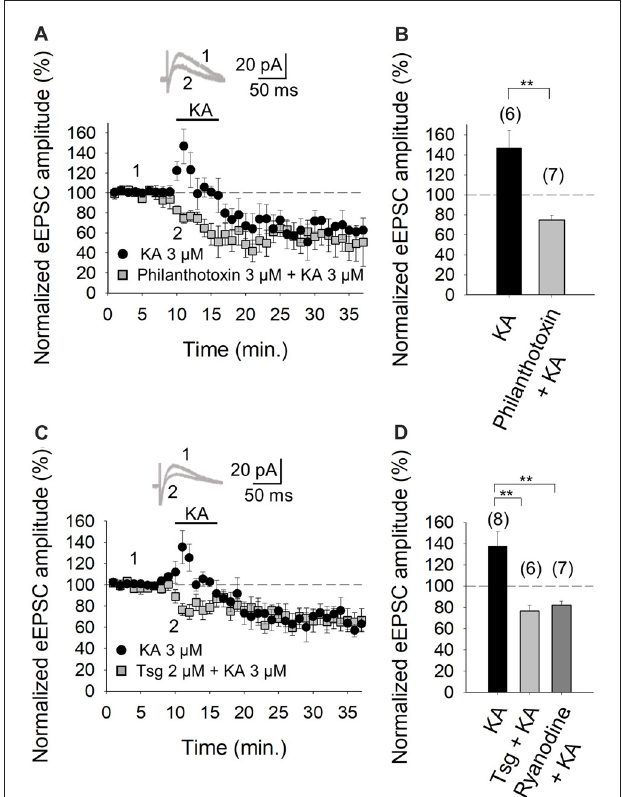
FIGURE 3 | Facilitation of glutamate release mediated by presynaptic kainate receptor (KAR) activation requires an increase of Ca 2 + in the cytosol at PF-PuC synapses. (A) Time-course of KA (3 µ M) effect on eEPSCs amplitude in control condition (circles) and in slices treated with philanthotoxin (squares). (B) Quantification of modulation observed in (A) . (C) Time-course of the effect of KA on eEPSCs amplitude in control slices (circles) and in thapsigargin-treated slices (squares). (D) In slices treated with thapsigargin or ryanodine, the increase of eEPSCs amplitude induced by KA is prevented. The number of slices (from two to three mice) is indicated in parenthesis at the top of each bar. Results are expressed as means ± SEM ( ∗∗ P < 0.01, Student’s t -test and